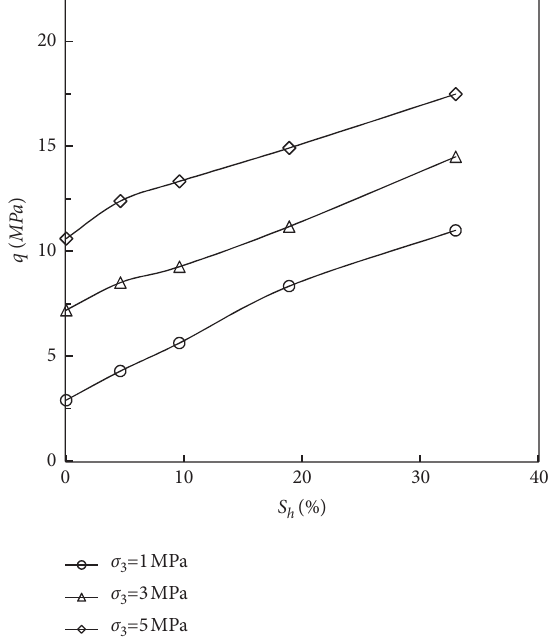
Figure 8: The relationship between failure strength and hydrate saturation.